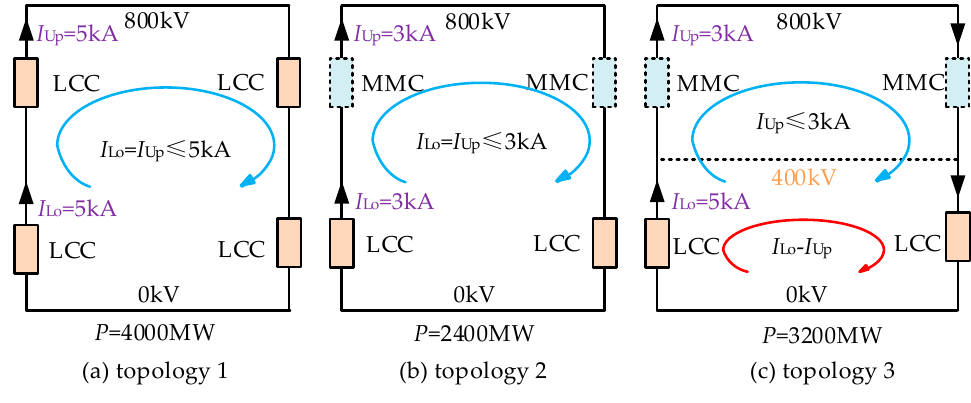
Figure 2. Comparison for different HVDC topologies.